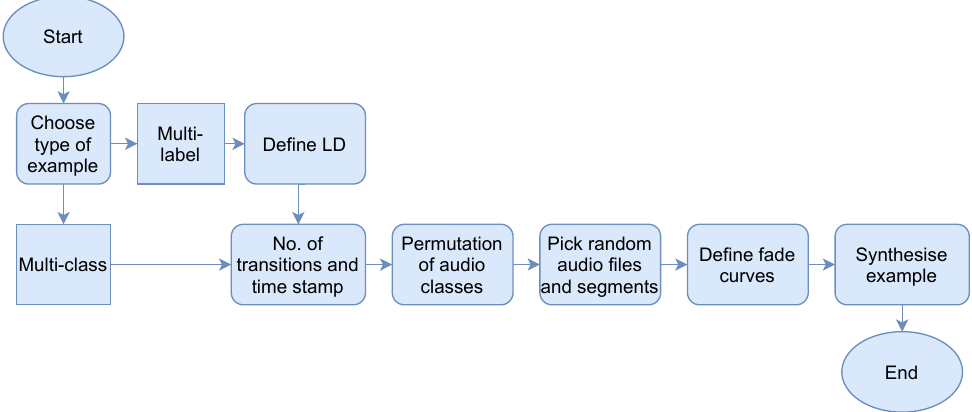
Figure 4. A flow diagram depicting an overview of the data synthesis